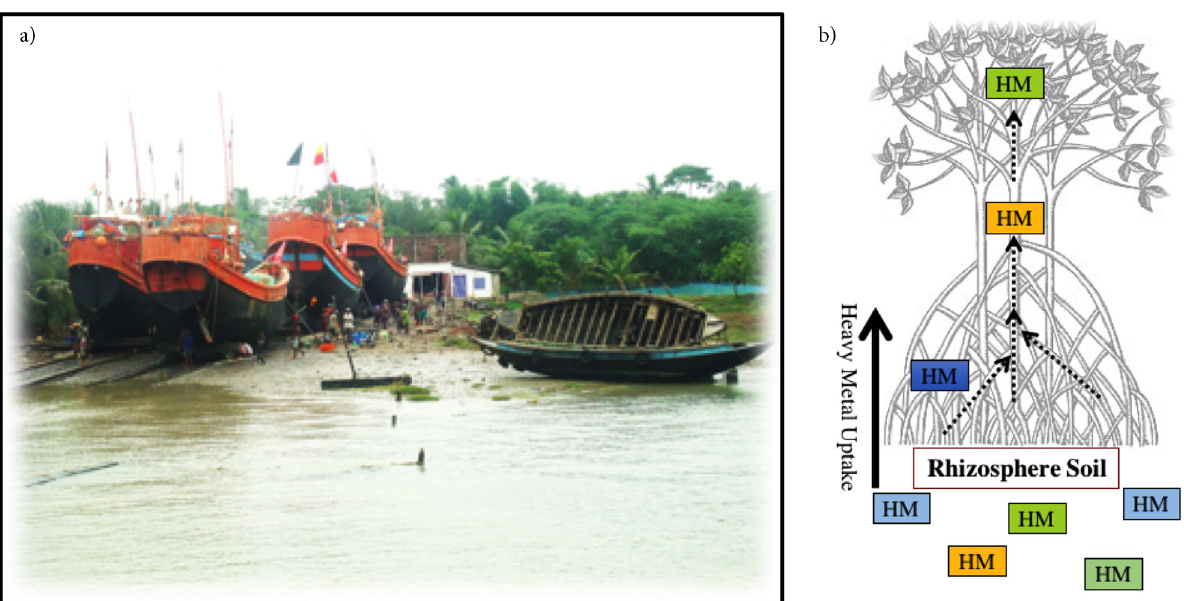
Figure 1. A potential point source of heavy metal (HM) pollution and its natural attenuation process in Indian Sundarbans: a) HM-rich antifouling paints that are used to coat the bottom of the fishing vessels and trawlers, which glide in the Hooghly-Matla estuarine complex of Indian Sundarbans; b) Mechanism of natural attenuation of HMs through phytoremediation by the mangroves and mangrove associate species of Indian Sundarbans. The black dotted arrows indicate the direction of HM